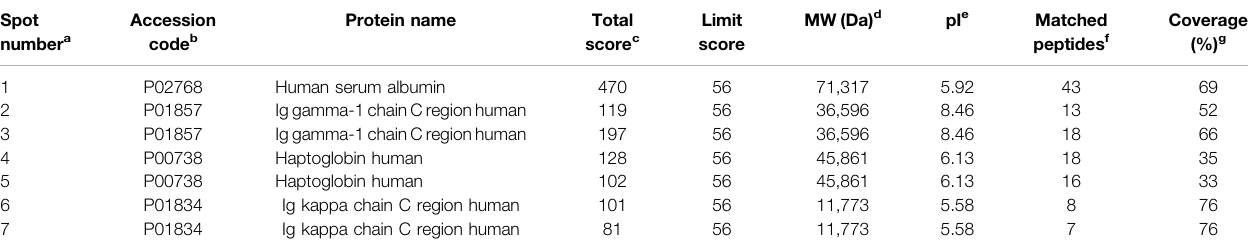
TABLE1| Identi fi cationofhumanserumproteinsastargetsforhaptenationbyCLV-tetraethylenglycol-Biotinbymassspectrometry.Dataundersuperscriptscthroughhare from MASCOT. Spot number